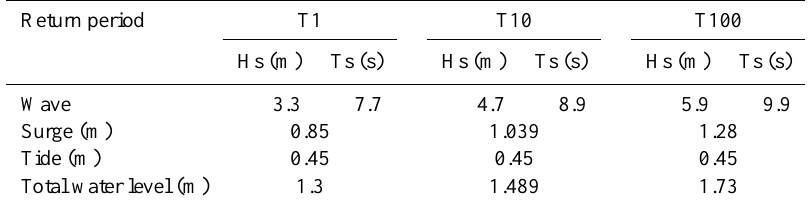
Table 1. Storm conditions used to design the three worst-case scenarios along profile